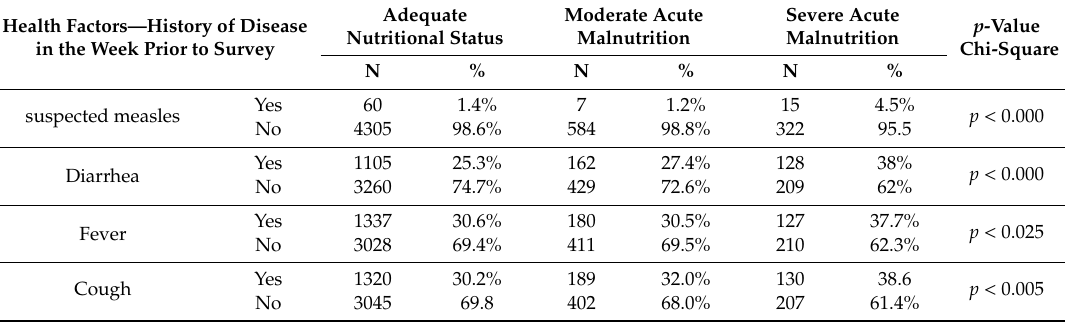
Table 5. Associations between health problems and the nutritional status of children under five years of age in the targeted areas of Ibb and Sana’a